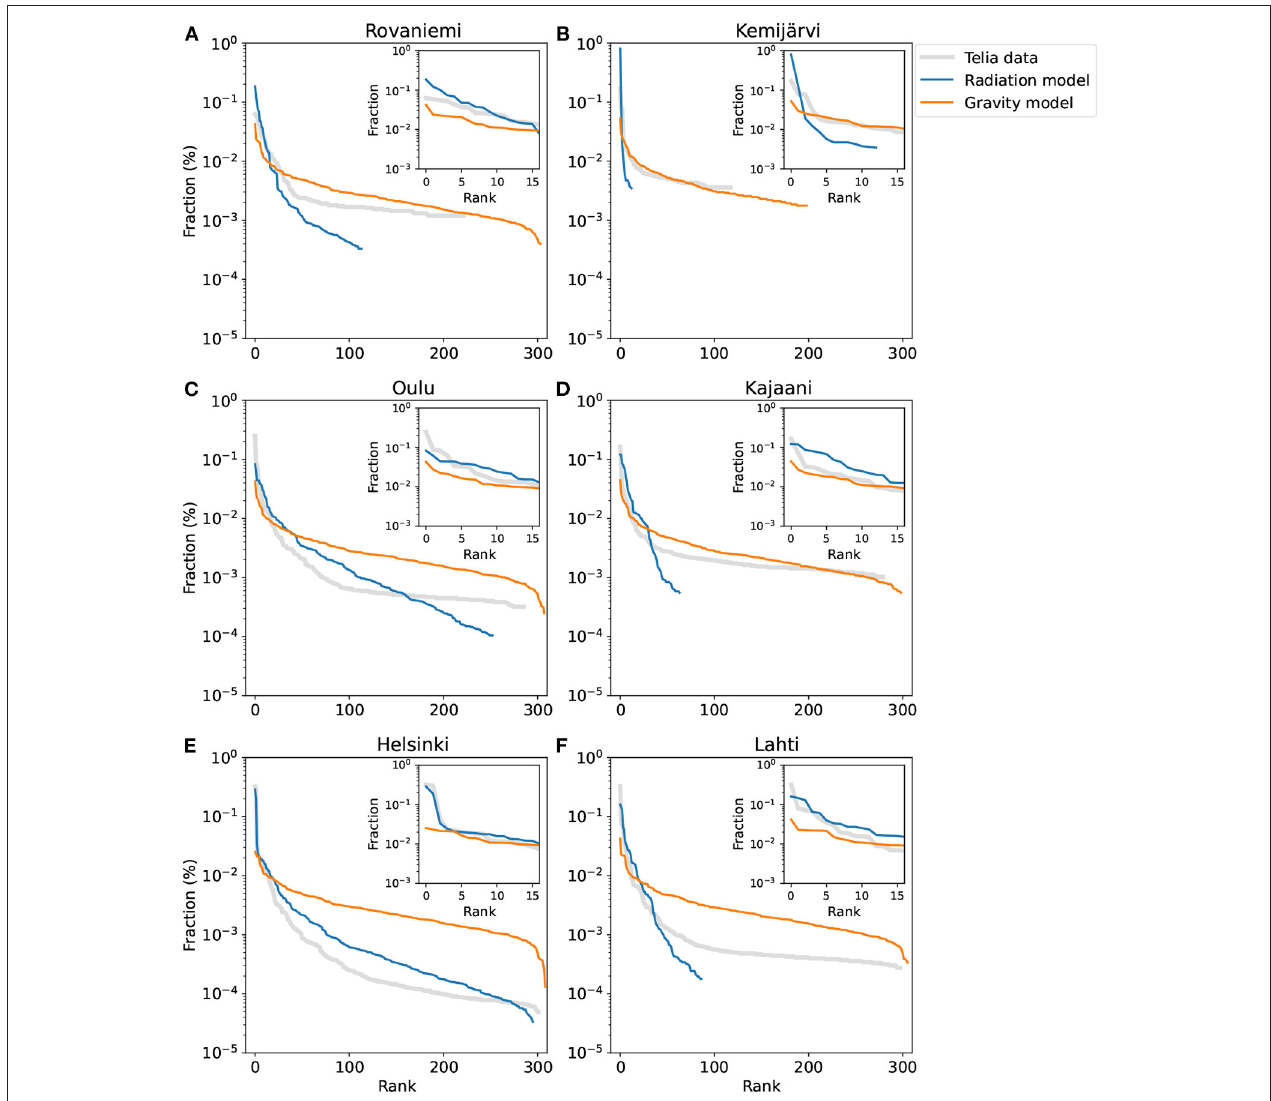
FIGURE 2 | Mobility signatures extracted from empirical data (mobile-phone data for 2019) and from theoretical models, for six selected cities across Finland. The two cities of the top row are in northern Finland, the cities of the middle row in central Finland, and the bottom cities in southern Finland. The first 15 top-ranked destinations are shown in the inset of each plot. Note that the cities on the left (A,C,E) are larger than the cities on the right (B,D,F)